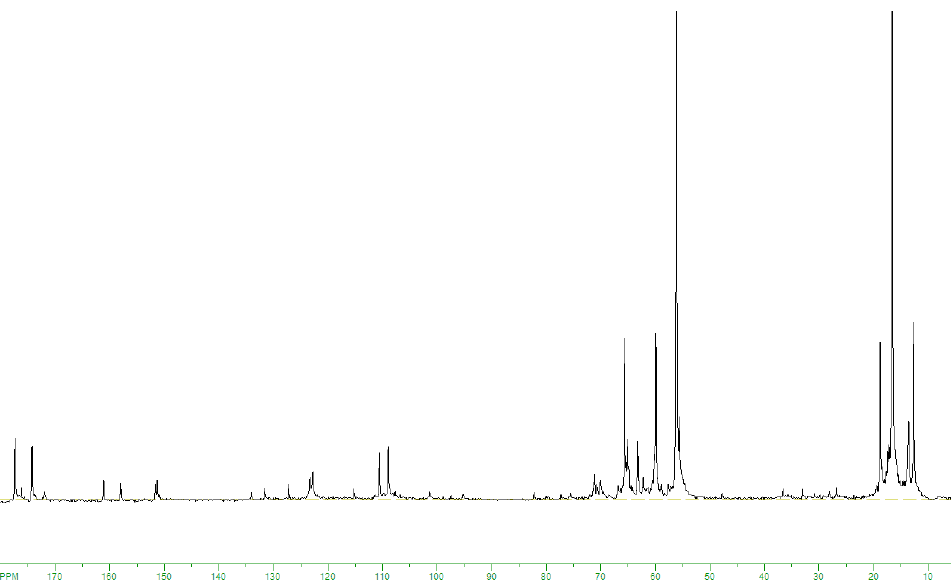
Figure 5. 13 C NMR spectrum of fructose conversion products on 20SnO 2 /Al 2 O 3 (13% fructose solution in ethanol, 160 ° С , 3 h; 100 MHz, NS=256, D0=4 s, D1=4 μ s (30°)).